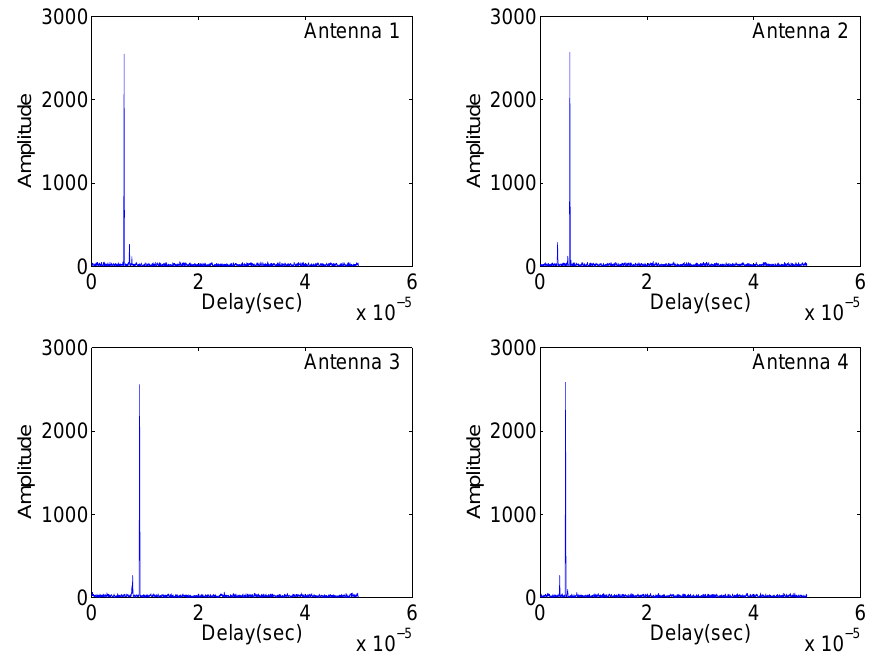
Figure 4. Matched filtering outputs of the four antennas in Case